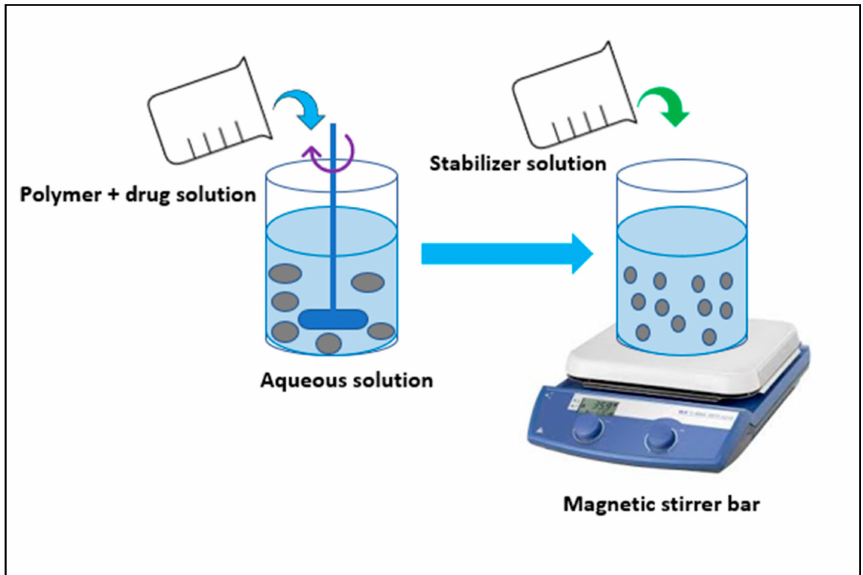
Figure 7. Nanoprecipitation